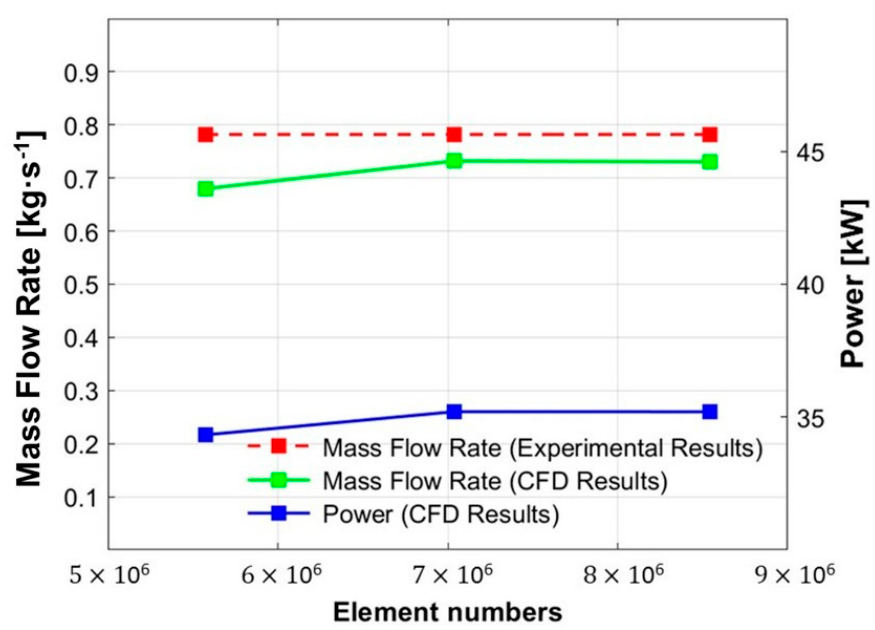
Figure 3. Mesh of fluid domain and rotor screw.